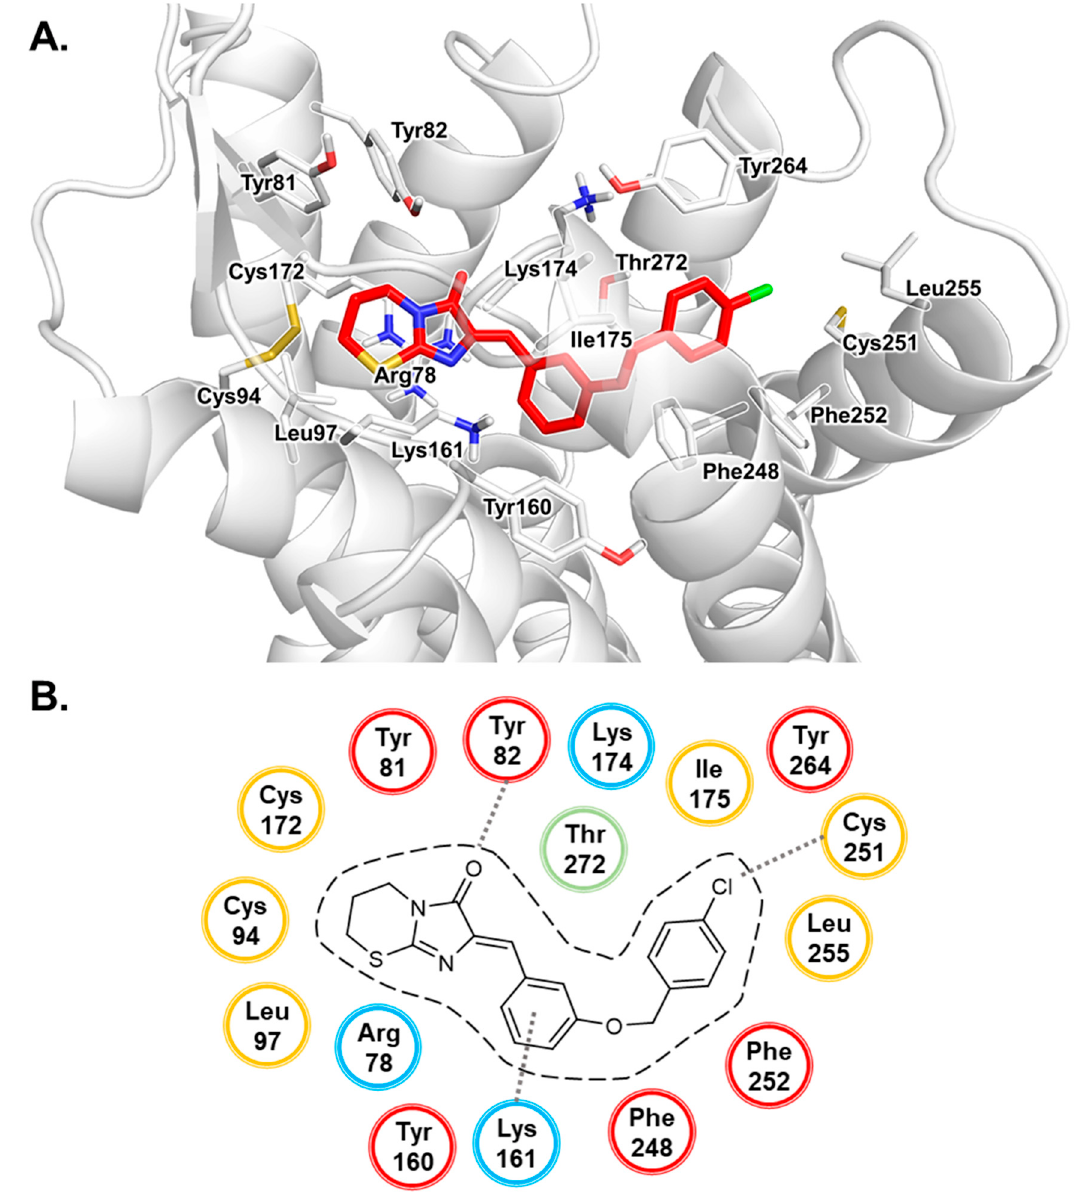
Figure 3. Proposed binding mode of antagonist 5 . ( A ) Docked pose of 5 in complex with the homology model of GPR18 shown with the residues forming the binding pocket. ( B ) Schematic 2D representation of the binding pocket. For color code, see Figure 2.